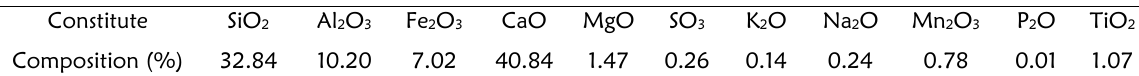
Table 2: Chemical composition of periwinkle shell powder